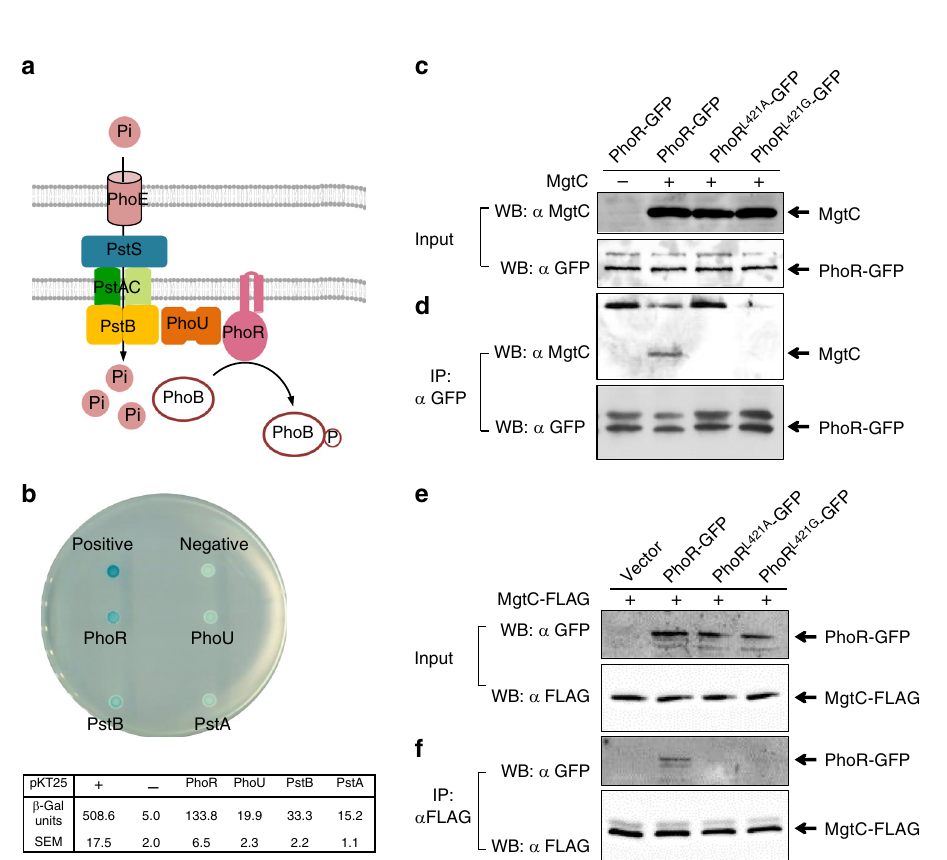
Fig. 2 MgtC interacts with the PhoR histidine kinase. a Schematic representation of seven components of proteins involved in phosphate signaling and the PhoE outer membrane porin. b Bacterial two-hybrid assay between MgtC and proteins involved in phosphate signaling. Escherichia coli BTH101 strains harboring two plasmids, pUT18 and pKT25 derivatives expressing a C-terminal fusion of the cyaA T18 fragment to the mgtC coding region and N-terminal fusions of the cyaA T25 fragment to either the coding regions of the phoR (PhoR), phoU (PhoU), pstB (PstB), pstA (PstA), and mgtR (positive) genes or the pKT25 empty vector (negative) were spotted onto LB plates containing 80 μ M X-Gal and 0.1 mM IPTG and incubated at 30 °C for 40 h. Blue colored colonies indicate a positive interaction. The average β -galactosidase activities ( β -Gal units) are shown below with the SEM ( n = 3, independent measurements). c , d The C-terminally GFP-tagged PhoR protein immunoprecipitates MgtC. c Crude extracts prepared from wild-type Salmonella coexpressing PhoR-GFP, PhoR Leu421Ala -GFP, or PhoR Leu421Gly -GFP and either MgtC or the empty vector (pBAD33) were detected with anti-MgtC (upper) and anti-GFP (lower) antibodies. d Eluted fractions prepared from strains listed above were detected with anti-MgtC (upper) and anti-GFP (lower) antibodies after immunoprecipitation with anti-GFP antibody-coated beads. e , f The C-terminally FLAG-tagged MgtC protein immunoprecipitates PhoR- GFP. e Crude extracts prepared from wild-type Salmonella coexpressing PhoR-GFP, PhoR Leu421Ala -GFP, or PhoR Leu421Gly -GFP, or the empty vector (pTGFP) and MgtC-FLAG were detected with anti-GFP (upper) and anti-FLAG (lower) antibodies. f Eluted fractions prepared from strains listed above were detected with anti-GFP (upper) and anti-FLAG (lower) antibodies after immunoprecipitation with anti-FLAG antibody-coated beads. Bacteria were grown for 3 h in N-minimal media containing 10 mM Mg 2 + and then for an additional hour in the same media containing 0.5 mM Mg 2 + and 1 mM L -arabinose